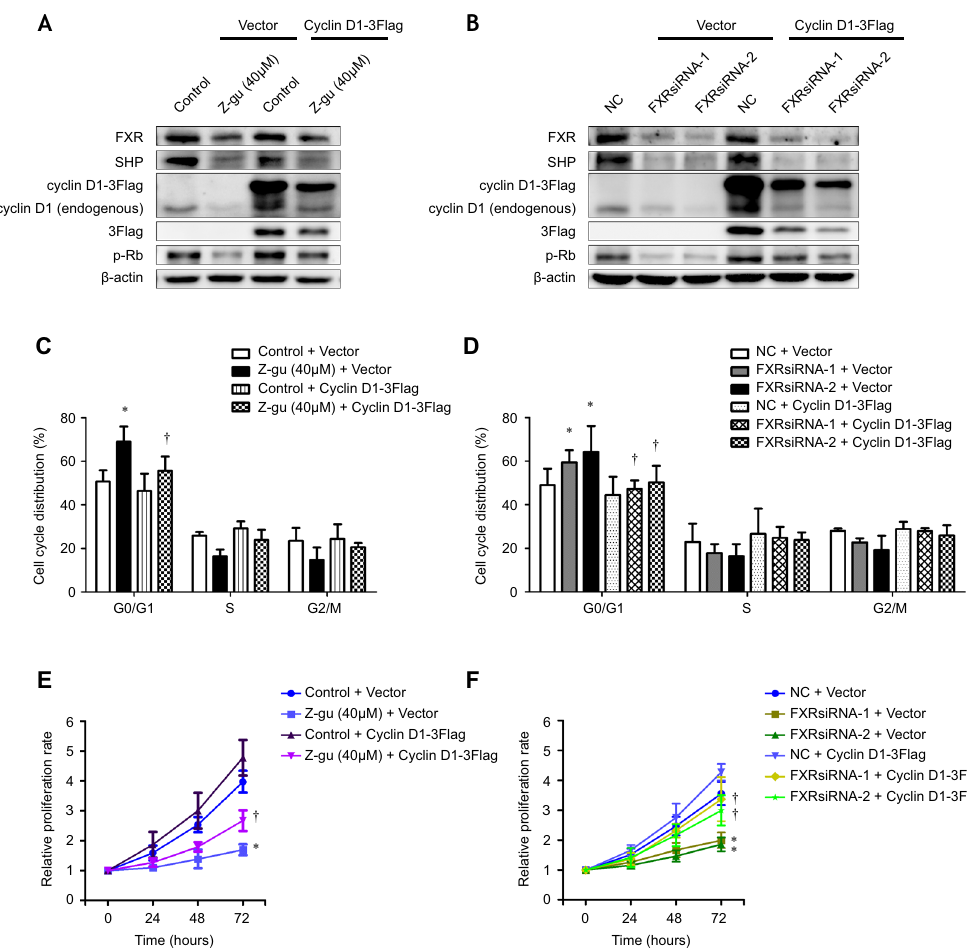
Figure 6. Overexpression of cyclin D1 rescues cell proliferation defects in FXR-suppressed NSCLC cells. Western blot analysis was performed to evaluate the expression of FXR, SHP, endogenous and ectopic cyclin D1, 3Flag, and p-Rb in H1975 cells that were treated with Z-guggulsterone (Z-gu, 40 μ M) ( A ) or transfected with NC- or FXR-siRNA sequences ( B ), in addition to the transfection with vector or cyclin D1-3Flag plasmid. 3Flag expression represented ectopic cyclin D1 expression. The cell cycle profile of H1975 cells was analyzed by flow cytometry two days after the treatment with Z-guggulsterone (40 μ M) with or without transfection of cyclin D1- 3Flag ( C ), or the cotransfection with FXRsiRNAs and/or cyclin D1-3Flag plasmid ( D ). The cell proliferation rate of H1975 cells was determined after the treatment with Z-guggulsterone (40 μ M) with or without transfection of cyclin D1-3Flag ( E ), or the cotransfection with FXRsiRNAs and/or cyclin D1-3Flag plasmid ( F ) by using SRB assay at different time points. All experiments were repeated at least three times. The data were shown as the mean ± SD. * p < 0.05, compared with the control + vector or NC + vector group, respectively; † p < 0.05, compared with the Z-guggulsterone (40 μ M) + vector or FXRsiRNAs + vector